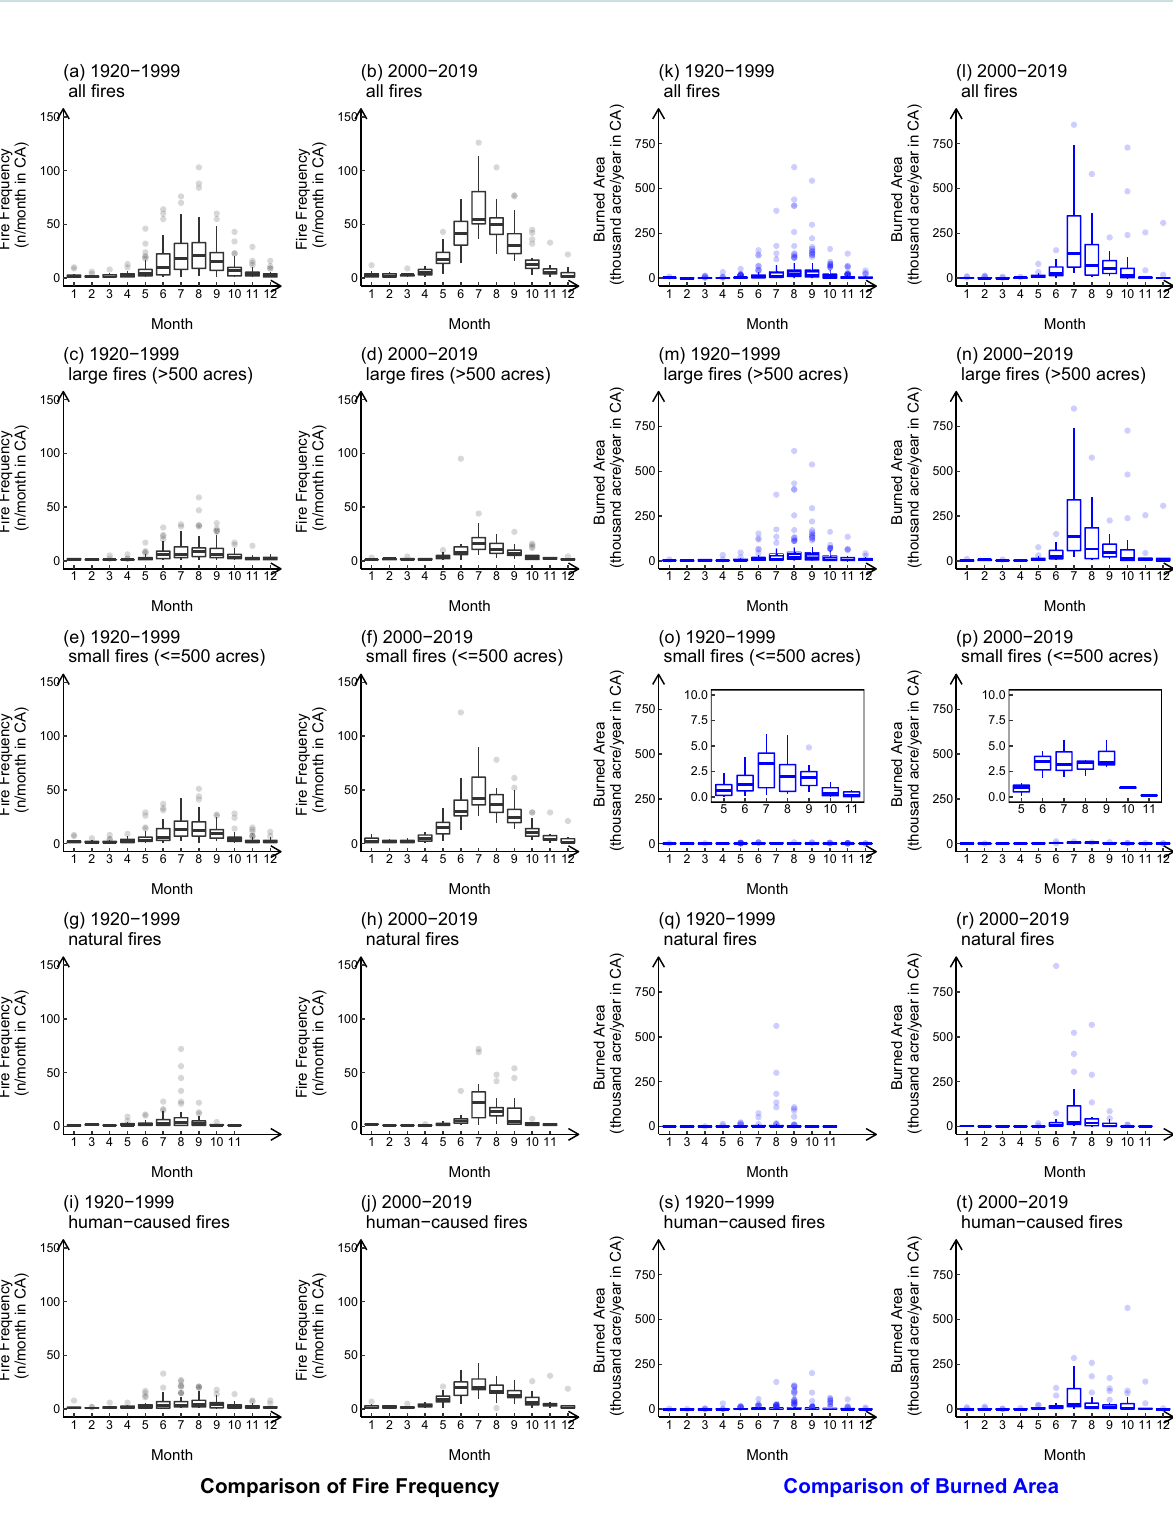
Figure 5. Seasonal variation of wildfire frequency and burned area from 1920 to 2019. The threshold of large 2 and small wildfires is 500 acre (2.02 km ). ( a – j show the seasonal variation of fire frequency, ( k – t ) show the seasonal variation of burned area; ( a , b , k , l ) are plots for all CA wildfires, ( c – f ) and ( m – p ) divided fires into large and small fire size group, ( g – j ) and ( q – t ) divided fires into natural and human-caused wildfire groups. The small plots in ( o ) and ( p ) zoom in to the burned area of 0–10 thousand